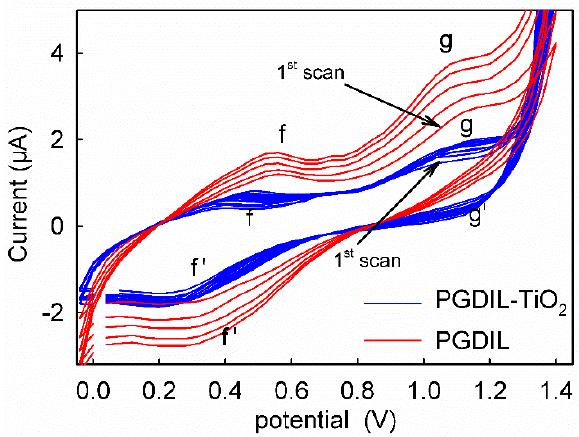
Figure 2. The cyclic voltammetry curve of GDIL. The arrows were the 1 st scan of the CV curves of GDIL and GDIL–TiO 2 on the Au electrode. g and g’ were the oxidation and reduction peak of the monomer, respectively. f and f’ were the oxidation and reduction peak of the polymer molecular chain, respectively.